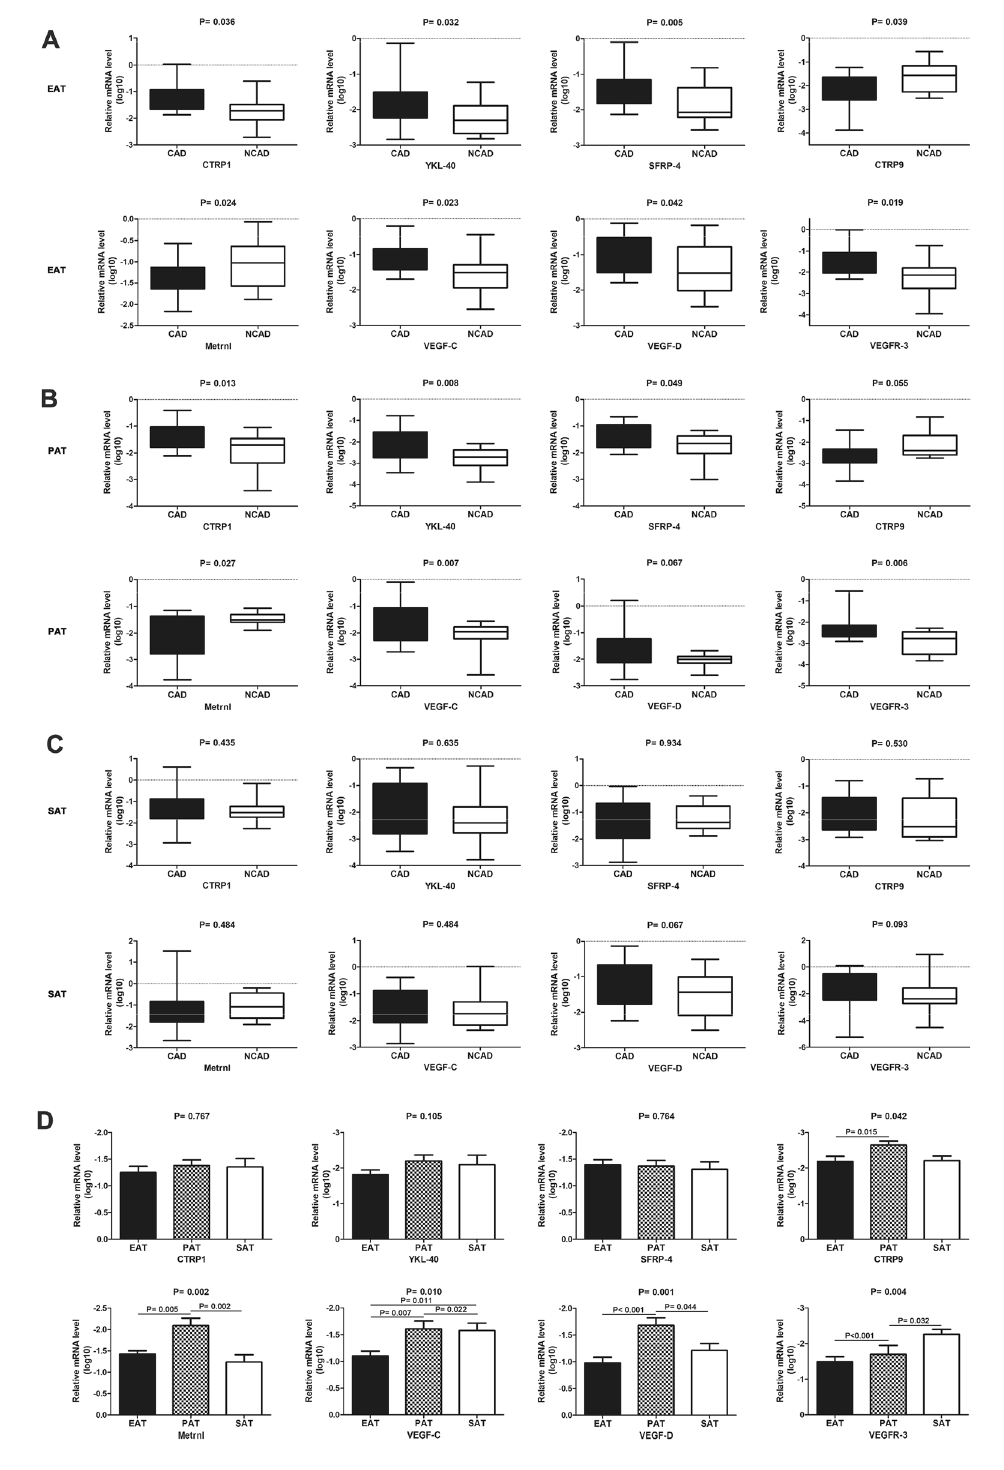
Figure 3. Cytoadipokines mRNA expression in adipose tissues in CAD (n = 26) and NCAD (n = 20) groups. ( A – C ) Quantitative analyses of CTRP1, YKL-40, SFRP-4, CTRP9, Metrnl, VEGF-C, VEGF-D, VEGFR-3 mRNA expression in EAT ( A ), PAT ( B ), SAT ( C ). ( D ) Quantitative analyses between EAT, PAT, SAT of CTRP1, YKL-40, SFRP-4, CTRP9, Metrnl, VEGF-C, VEGF-D, VEGFR-3 mRNA expression in CAD group (n = 26). The Mann–Whitney U test was used to compare the relationship between the CAD and NCAD groups. The Kruskal–Wallis H test was used for the comparison among the three groups, and the multiple comparison between the groups was used “all pairwise”, the test level was adjusted to P =